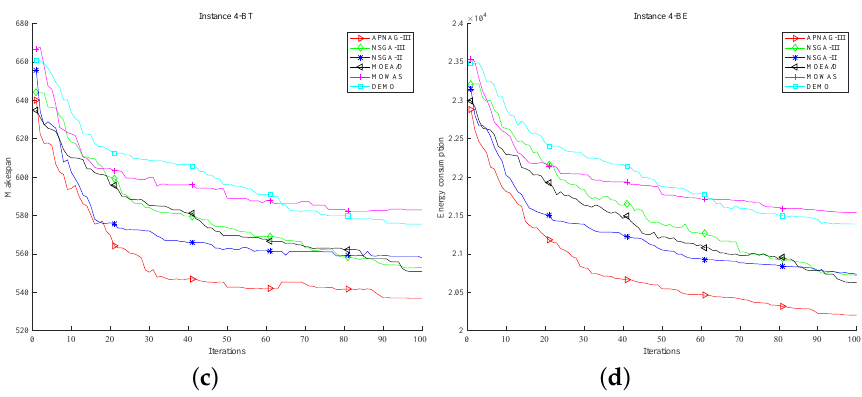
Figure 6. The convergence curve of BT and BE for Instance 3 and Instance 4. ( a ) BT of Instance 3;